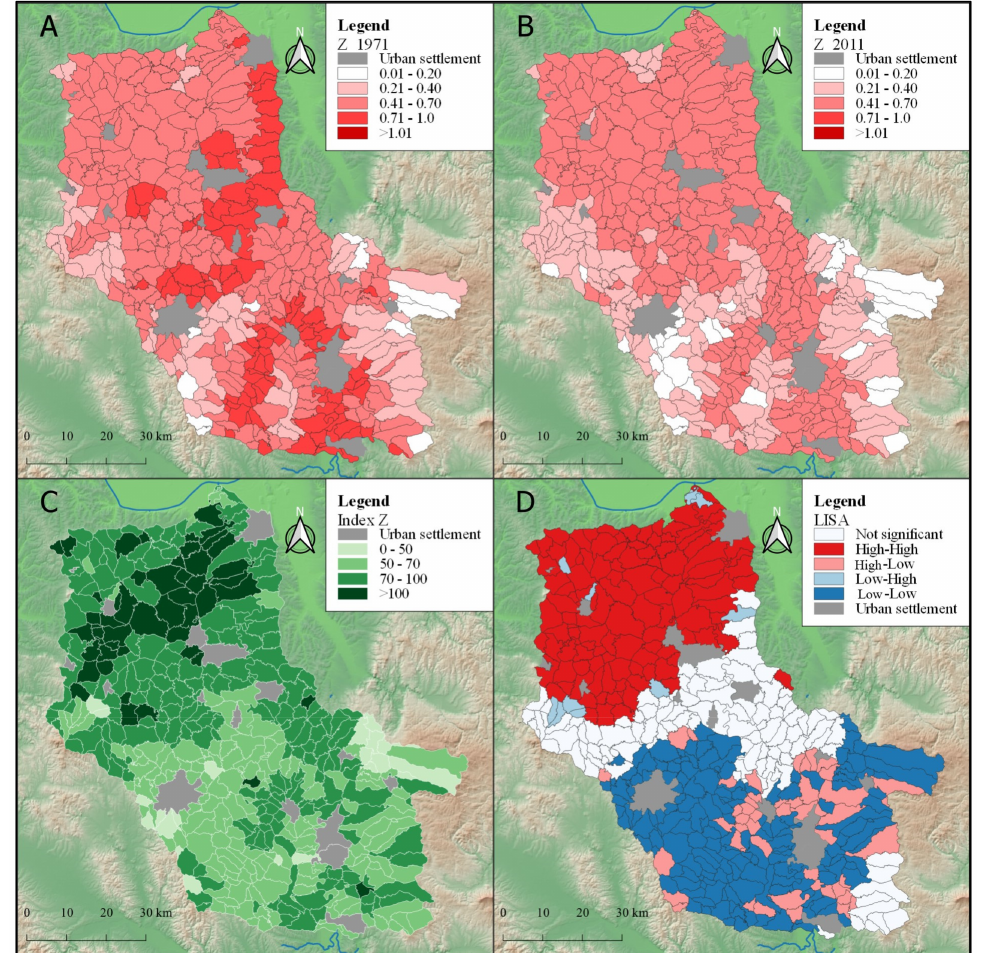
Figure 2. The average coefficient of erosion Z in rural settlements of the Velika Morava River Basin in 1971 ( A ) and 2011 ( B ); Index Z for the period 1971–2011 ( C ); LISA univariate cluster map of Index Z for the period of 1971–2011 ( D